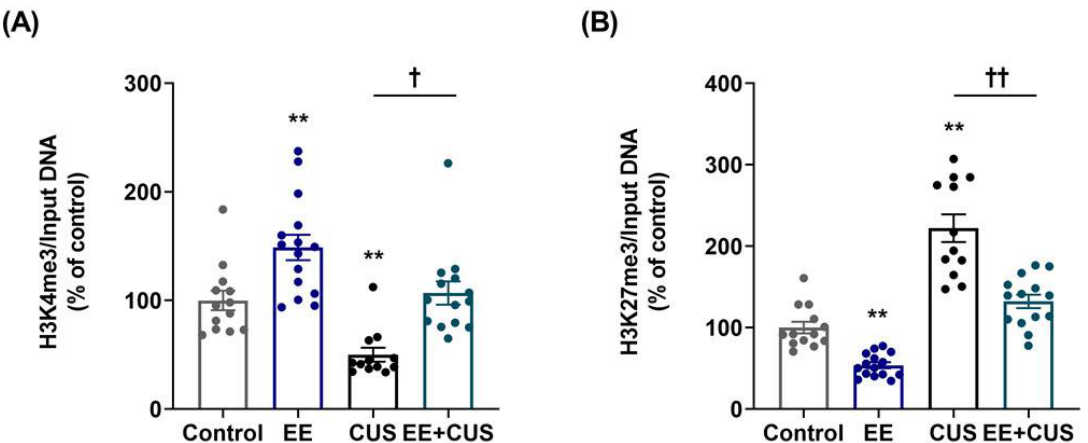
Figure 5. Effects of EE and CUS on the levels of histone H3 methylation at the p11 promoter in the hippocampus. The levels of histone H3 trimethylated K4 (H3K4me3, ( A )) and K27 (H3K27me3, ( B )) at the p11 promoter in the hippocampus were measured by ChIP assay using antibodies to H3K4me3 and H3K27me3. Data were normalized to input DNA and are expressed as values relative to the control group using the 2 − ∆∆ ct method. Data represent mean ± SEM expressed as a percentage of the control group. ** p < 0.01 vs. control group; † p < 0.05 vs. CUS group; †† p < 0.01 vs. CUS group. n = 12 – 15 animals/group.